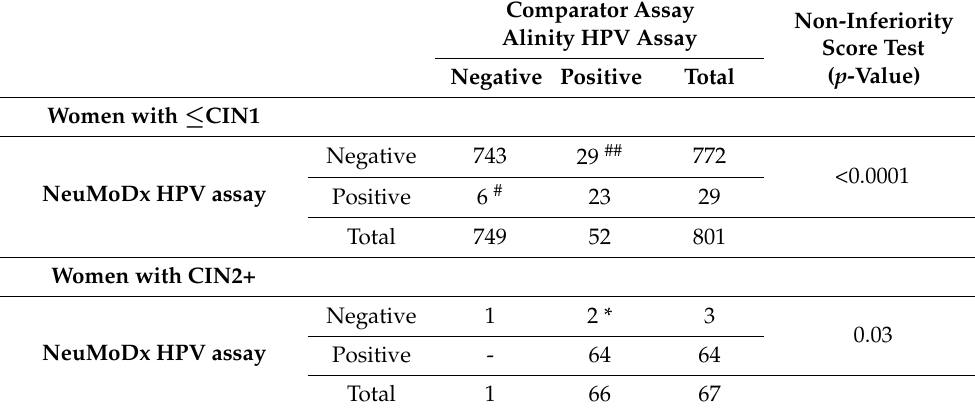
Table 7. Clinical performance for CIN2+ of NeuMoDx HPV assay in women aged >30 years